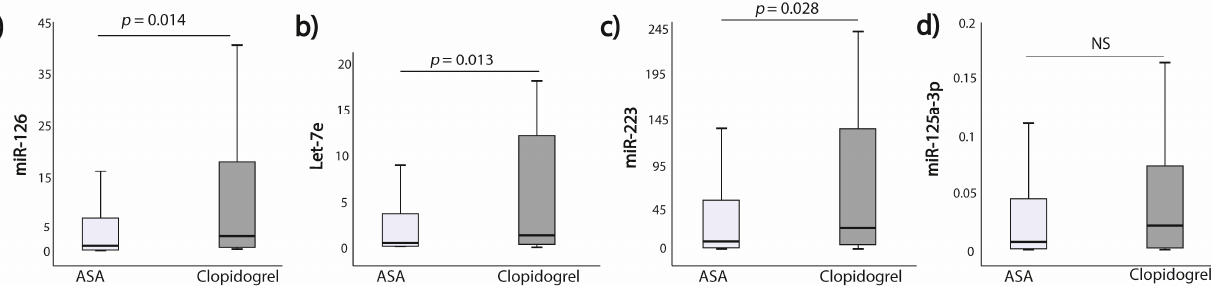
Figure 4. MiRNAs expressions in regard to antiplatelet treatment (ASA vs. Clopidogrel) ( a ) miR-126; ( b ) Let-7e; ( c ) miR- 223; ( d ) miR-125a-3p.